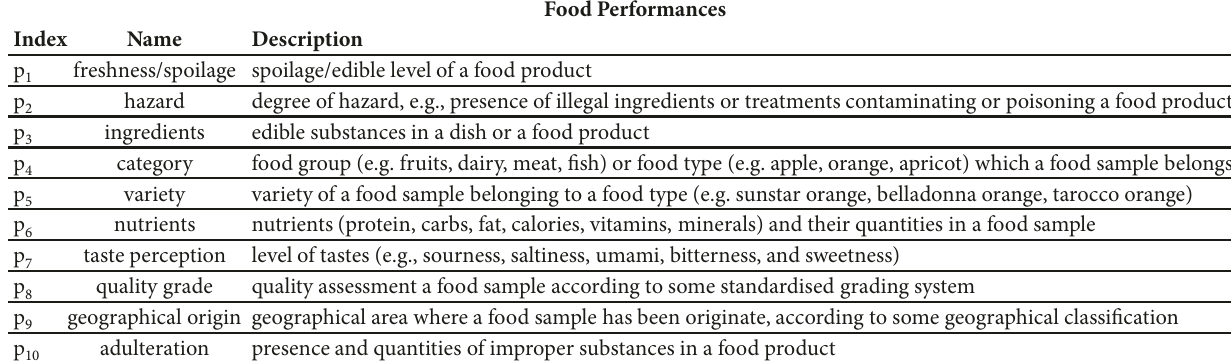
Table 3: The set P of food performances.